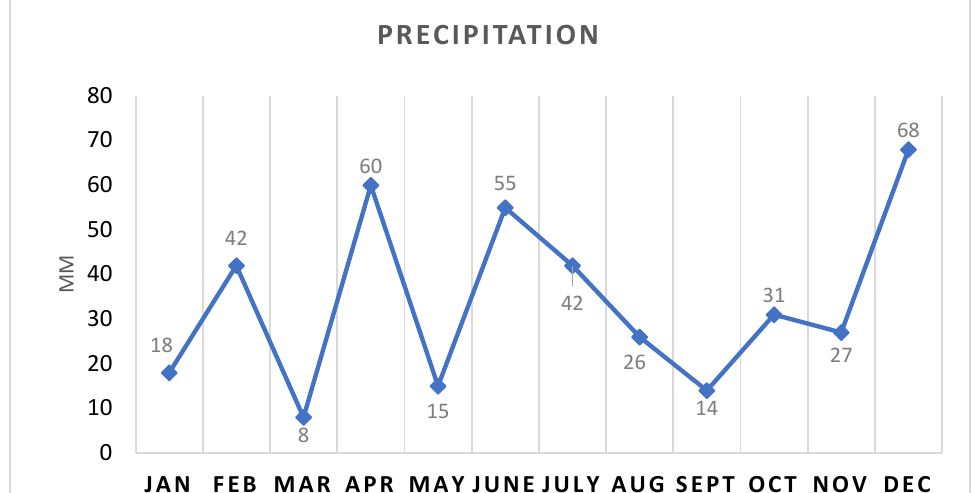
Figure 6. Number of the days with precipitation.